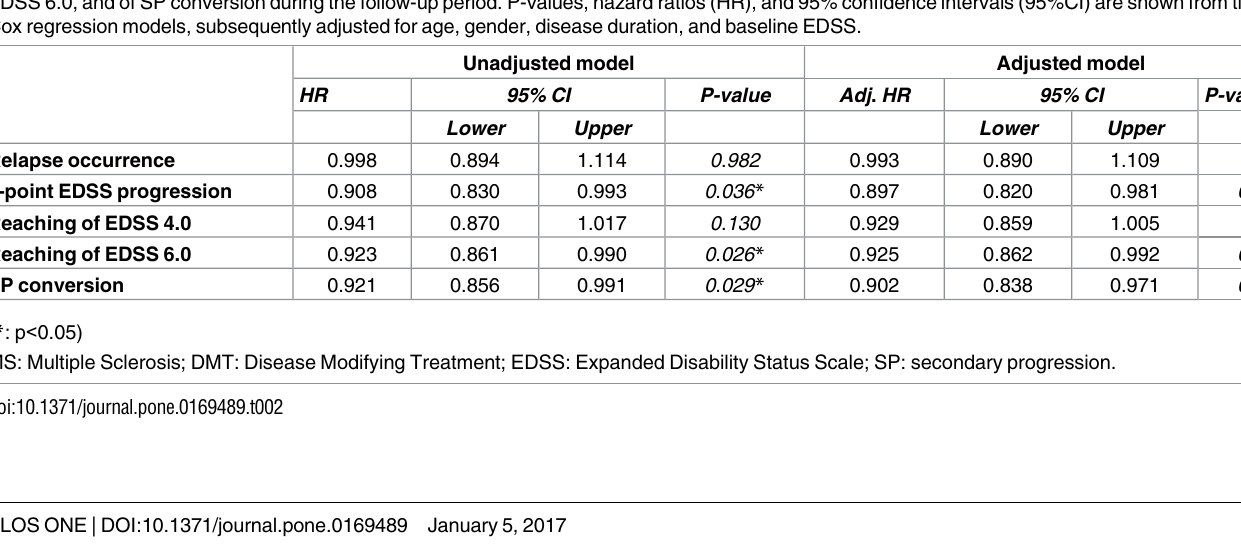
Fig 2. Kaplan-Meier curves for the probability of relapse occurrence, of 1-point EDSS progression, of reaching of EDSS 4.0, of reaching of EDSS 6.0, and of SP conversion, in relation to annual healthcare